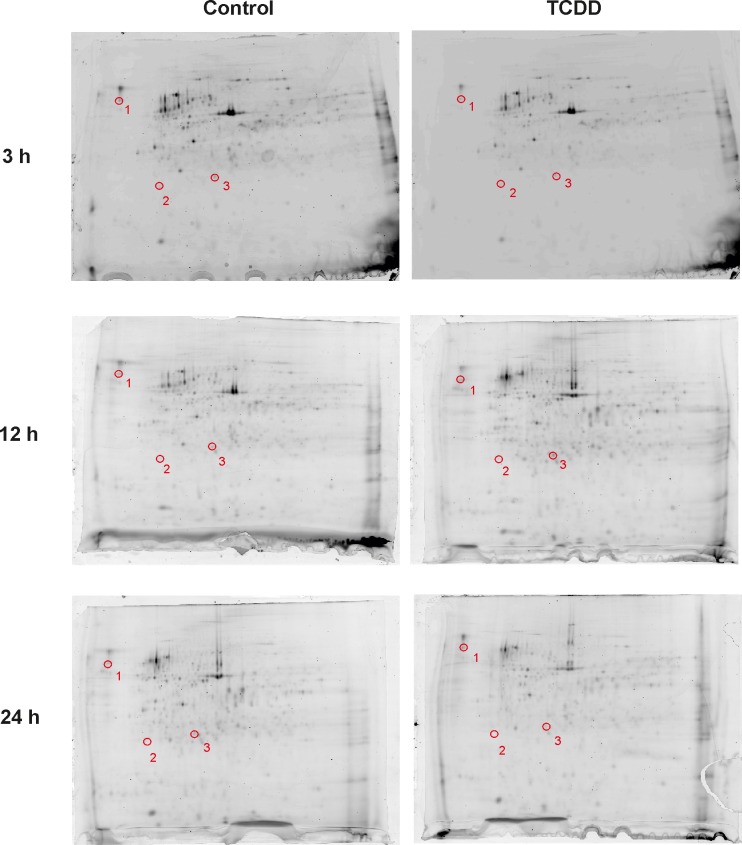
Exemplary images of 2D-DIGE analysis of AhR-silenced porcine granulosa cells (TR).The cells were cultured in the absence (Control) and in the presence of TCDD (TCDD) for 3, 12 or 24 h. The numbered protein spots outlined in red represent the proteins that were identified as significantly changed (p<0.05) by TCDD treatment in TR cells.